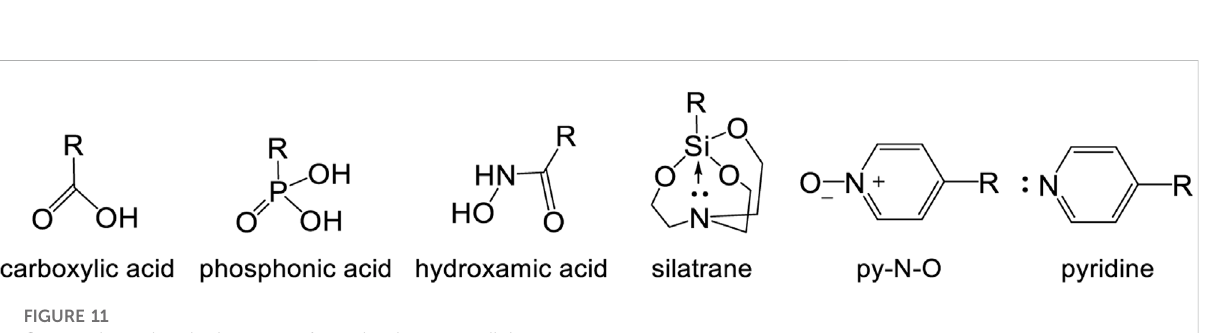
FIGURE 11 Commonly used anchoring groups for molecular water splitting